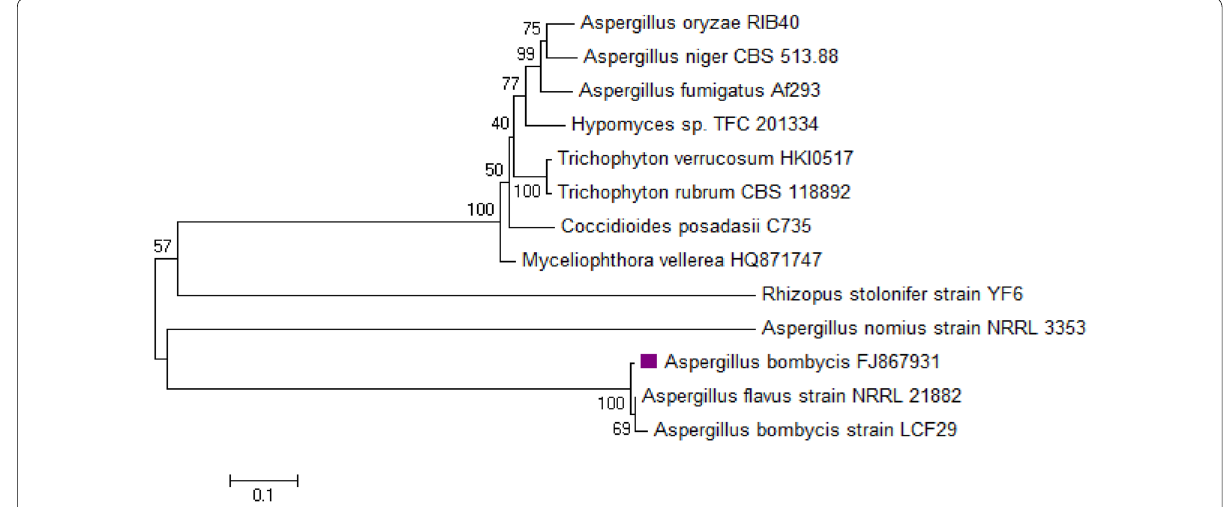
Fig. 2 Phylogenetic tree of fungal culture was constructed using the neighbor-joining method with the aid of MEGA 6.0